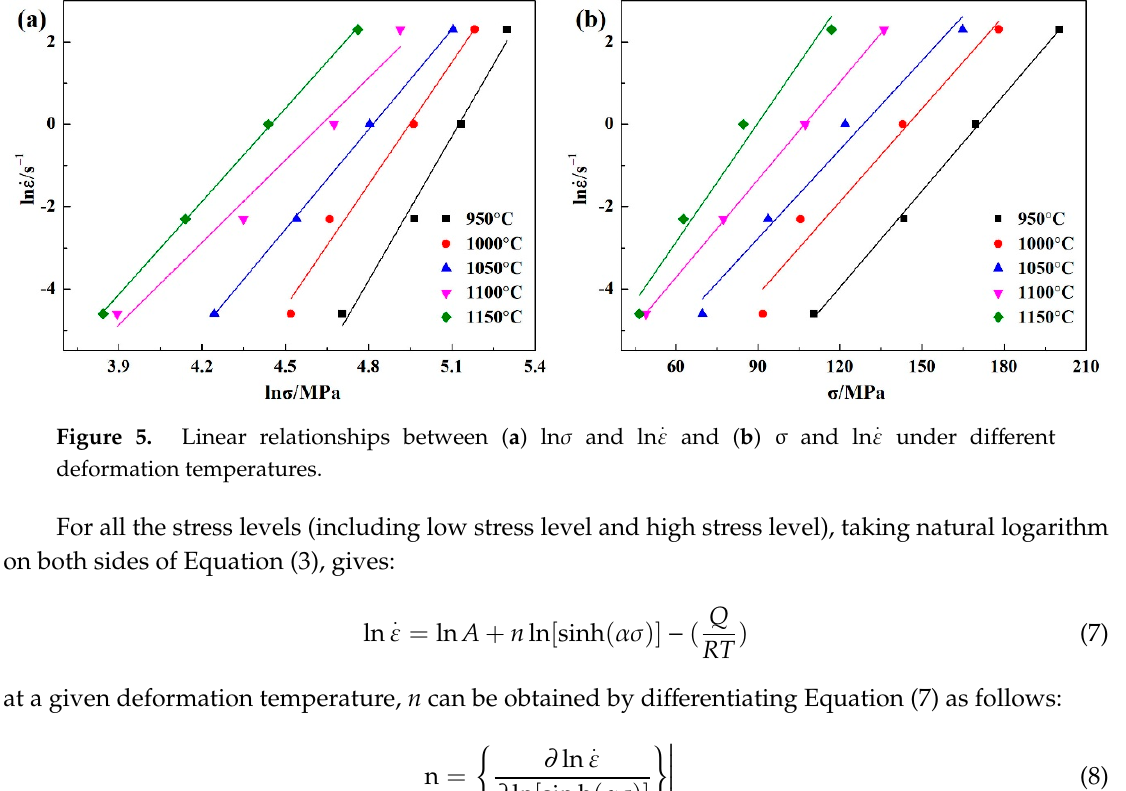
Figure 5. Linear relationships between ( a ) ln σ and ln ε(cid:4662) and ( b ) σ and ln ε(cid:4662) under different deformation temperatures.